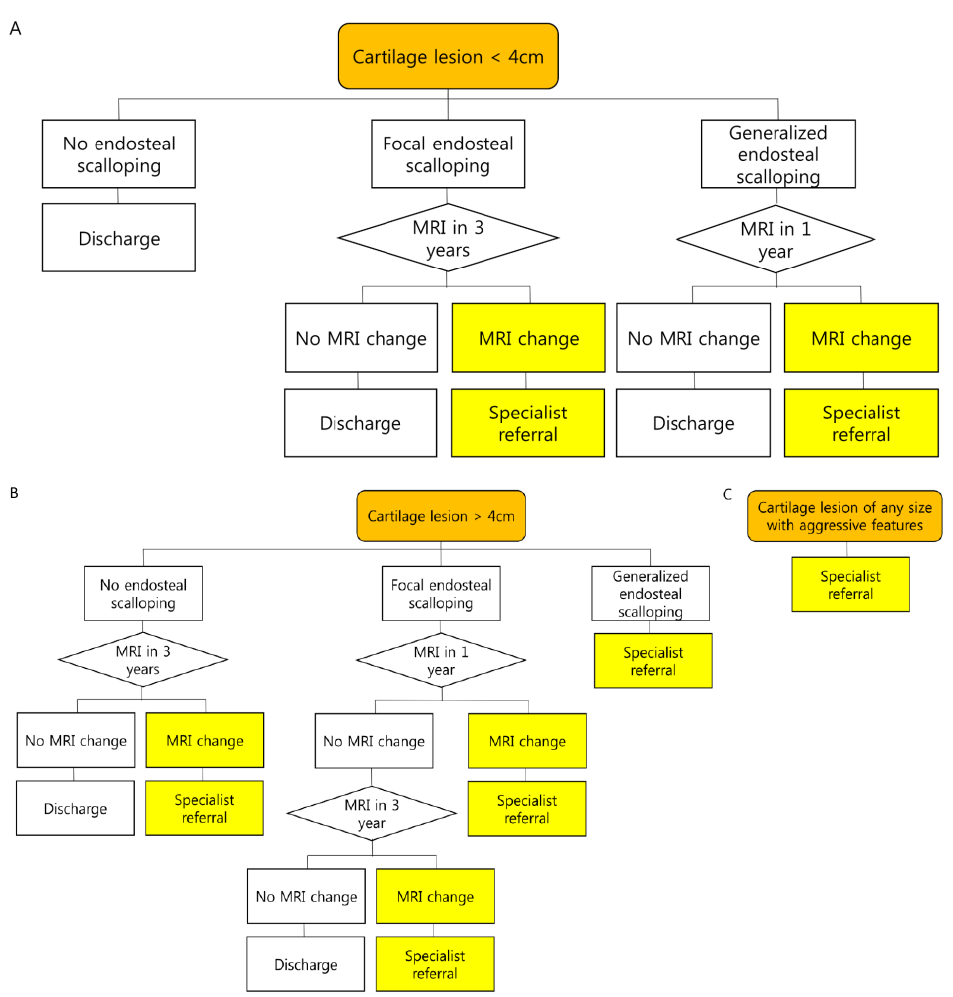
Figure 16. Birmingham Atypical Cartilaginous Tumor Imaging Protocol applied to cartilage lesions in the proximal humerus and around the knee [79]. ( A ) Cartilage lesion < 4 cm, focal endosteal scalloping ≤ 10% or 36 ◦ of lesion circumference on the axial image with the greatest involvement; generalized endosteal scalloping ≥ 10% or 36 ◦ of lesion circumference on the axial image with the greatest involvement; MRI change = increase in longitudinal length of lesion ≥ 1 cm and/or development of aggressive features including increasing endosteal scalloping. ( B ) Cartilage lesion > 4 cm. ( C ) Cartilage lesion of any size with aggressive features (bone expansion and/or cortical thickening, periostitis, cortical destruction, and soft tissue mass).